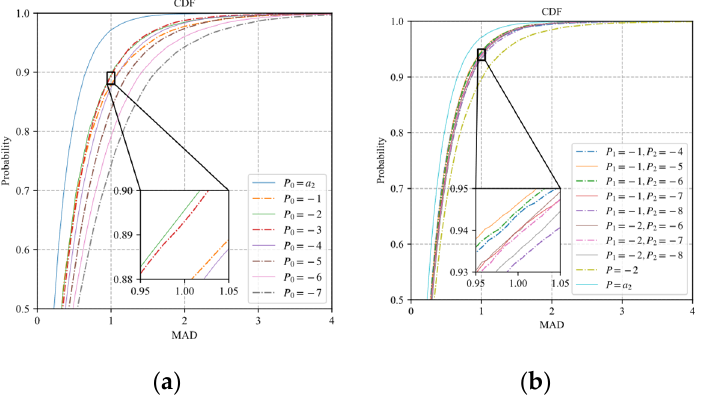
Figure 7. The CDF curves of MADs of the prediction distortion vectors: ( a ) model (30); ( b ) model (31).